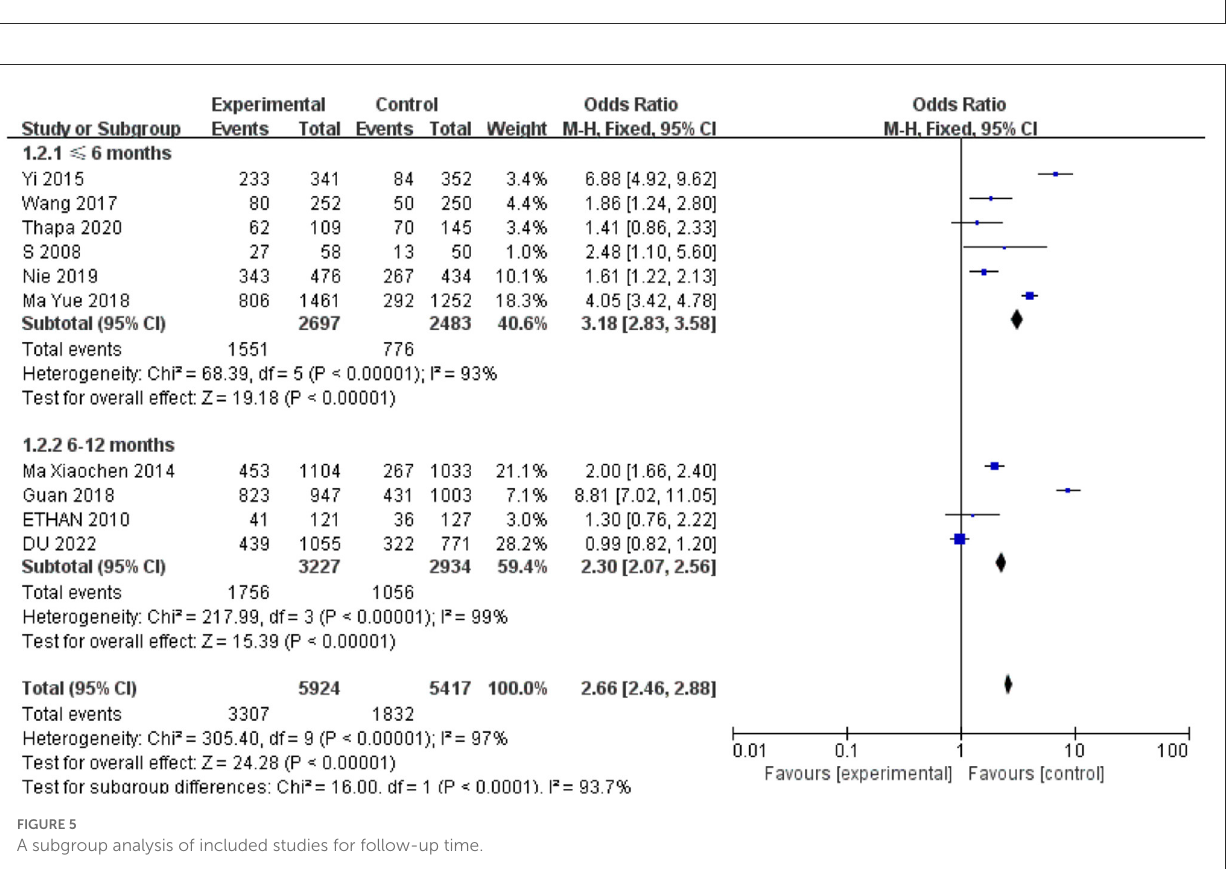
FIGURE4 Risk of bias graph for included studies.